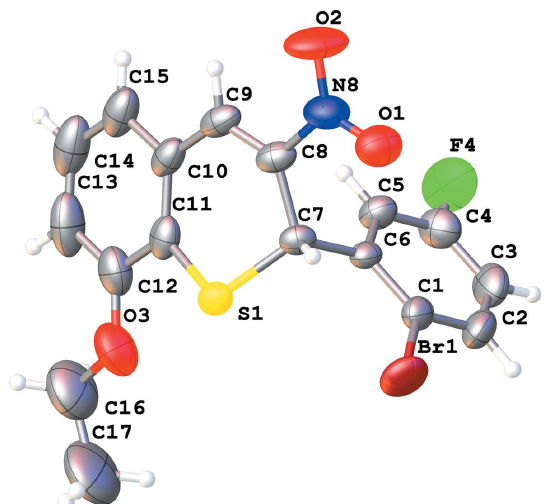
Figure 1 The molecular structure of 2-(2-bromo-5-fluorophenyl)-8-ethoxy-3-nitro- 2 H -thiochromene ( A ), showing the atom labeling. Displacement ellipsoids are drawn at the 50% probability level. Figure 2